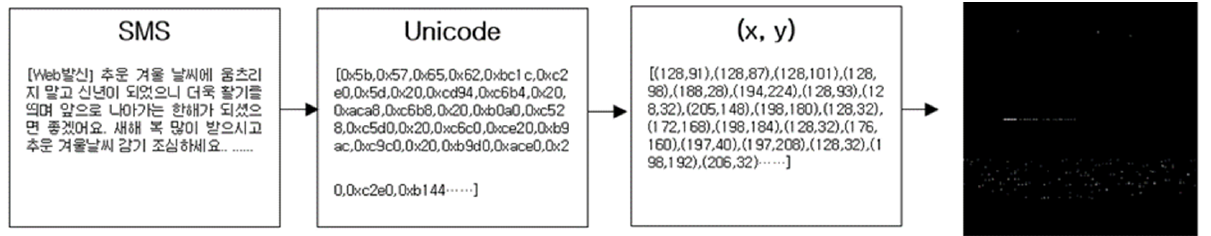
Figure 7. Changing process from text to a grayscale image.